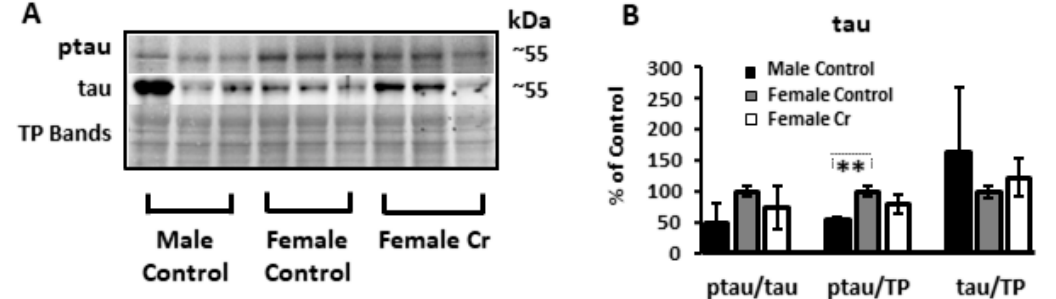
Figure 11. Relative hippocampal levels of hyperphosphorylated tau protein in control and Cr-supplemented 3xTg mice. ( A ) Representative Western blots detecting hyperphosphorylated tau (ptau) and total tau. Total protein (TP) was measured with Ponceau S staining (representative bands shown to indicate sample loading. ( B ) Bar graph depicts densitometry values after normalization to total tau and to total protein (TP) bands, which are expressed as the percentage change from female control-fed means (100%) ± SD. ANOVA or Brown–Forsythe: n = 3. ** p < 0.01.